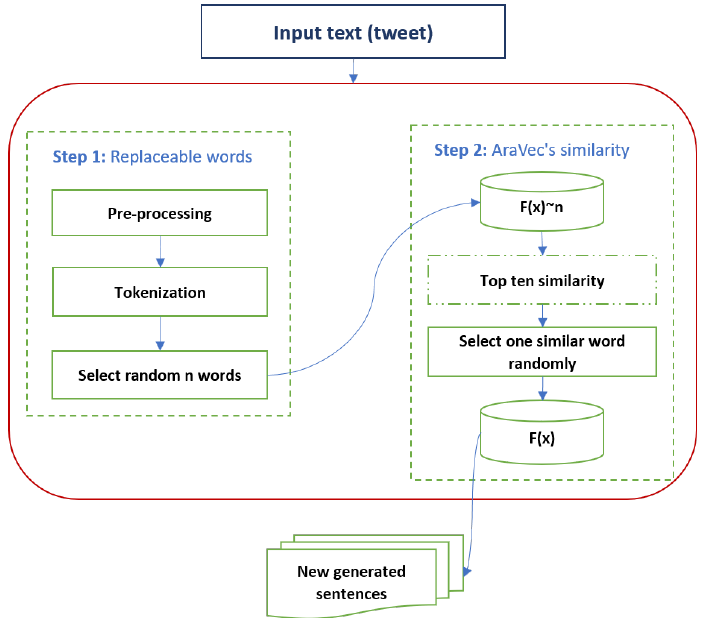
Figure 2. Arabic text data augmentation